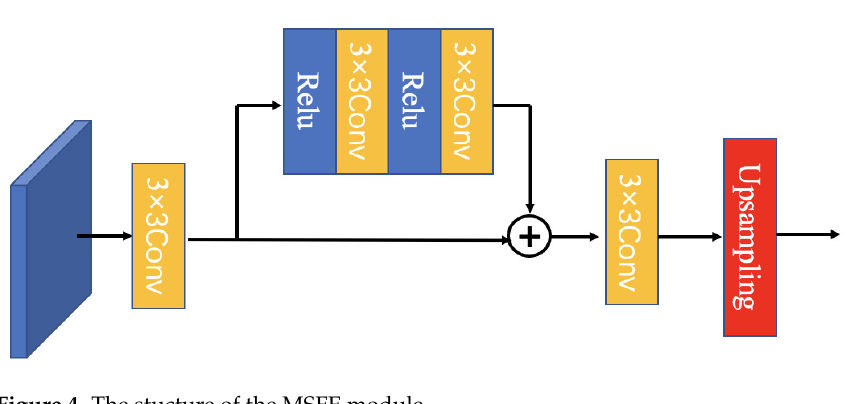
Figure 4. The stucture of the MSFE